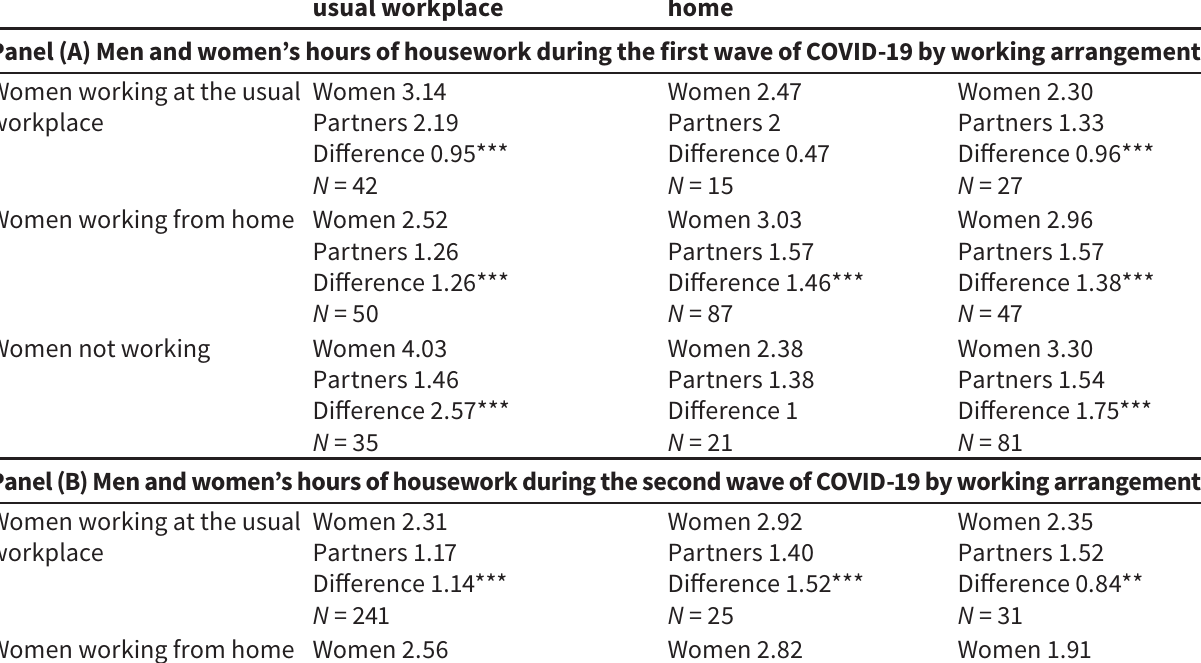
Table 2 Hours of housework and childcare during the first and second waves of COVID-19 Partners working at the Partners working from Partners not working usual workplace home Panel (A) Men and women’s hours of housework during the first wave of COVID-19 by working arrangement a Women working at the usual workplace